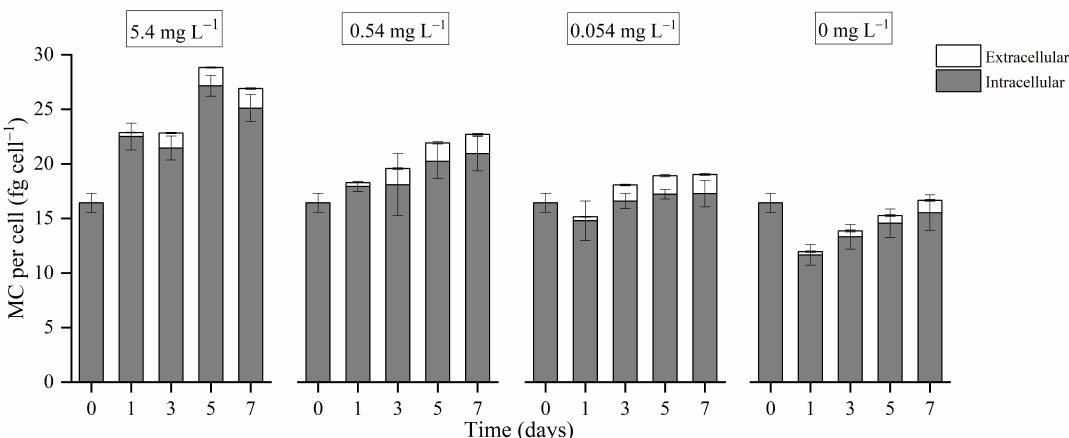
Figure 3. Changes in microcystin (MC) concentration in cultures of Microcystis aeruginosa FACHB-905 at different initial phosphorus concentrations. Numbers within the boxes on the top indicate initial phosphorus concentrations in the corresponding groups. Columns with dark grey filling represent intracellular MC. Columns with white filling represent extracellular MC. Error bars indicate standard deviation from three biological